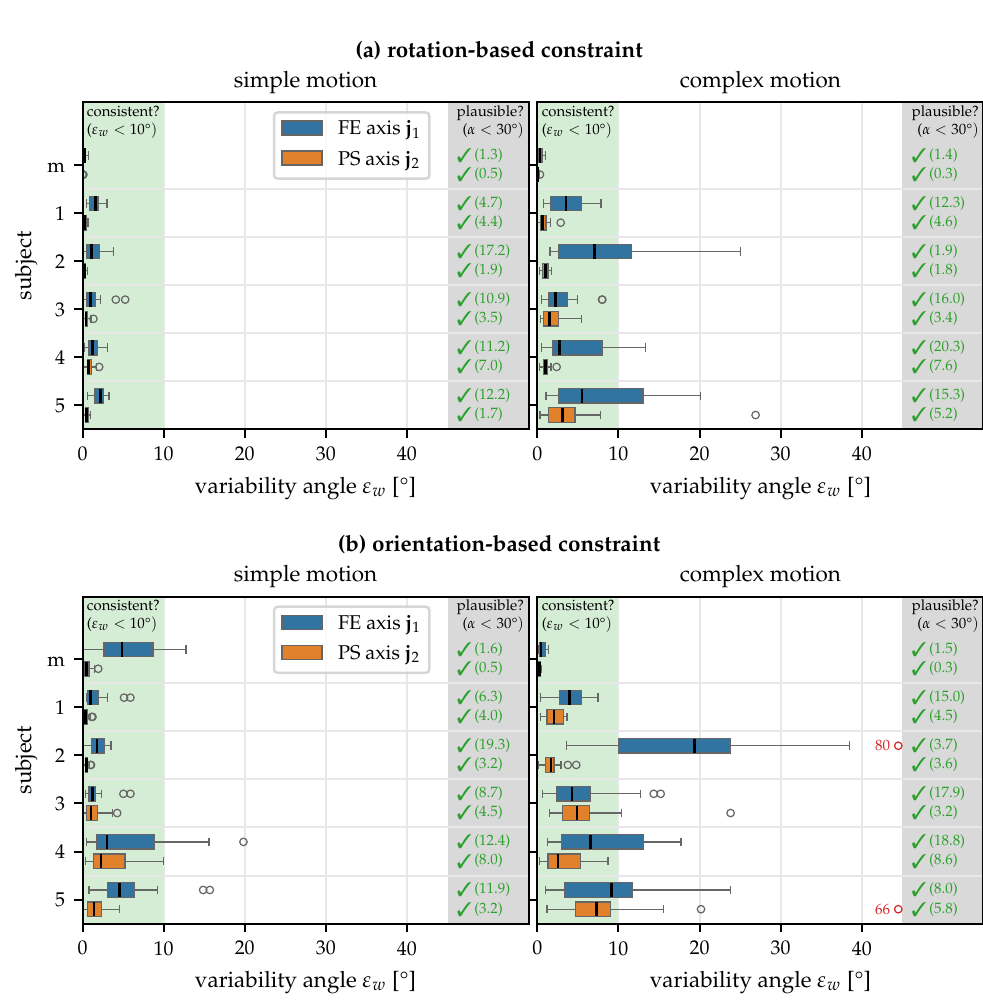
Figure 6. Consistency and plausibility results for the first experiment with the ( a ) rotation-based constraint and the ( b ) orientation-based constraint, for two motion types and for five human subjects and a mechanical joint (m). The proposed methods estimate plausible axes for all subjects and all motions. The rotation-based constraint yields more consistent estimates than the orientation-based constraint, and the simple motion leads to better results than the complex motion.